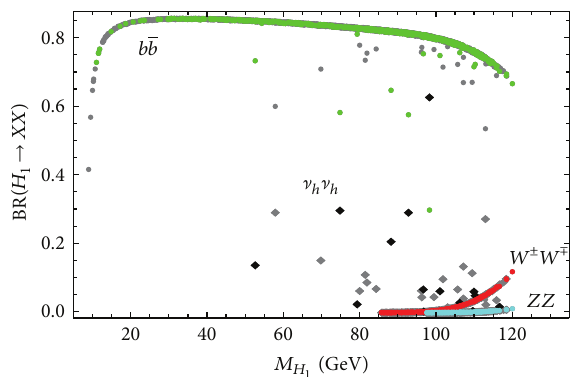
Figure 7: Same as in Figure 6 for the lightest Higgs boson ( 𝐻 1 ).